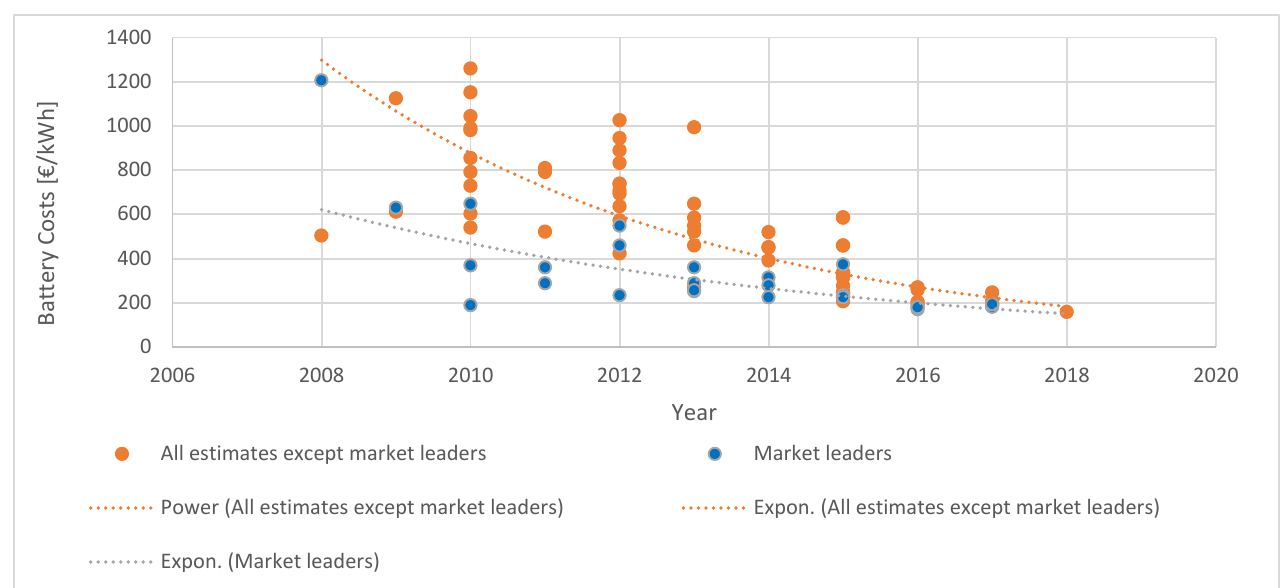
Figure 7. Li-ion battery pack costs based on data from literature reviews.